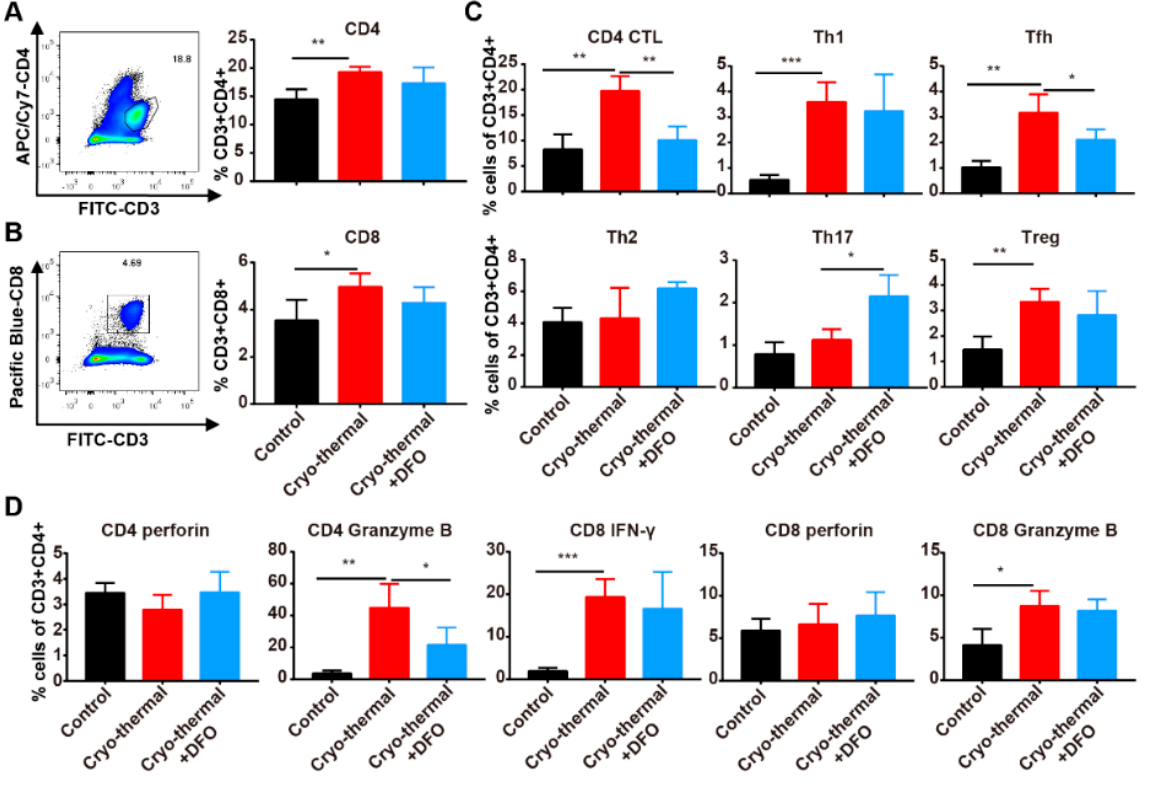
Figure 7. Iron promoted the differentiation of CD4 CTL and Tfh. Mice were sacrificed and spleens were harvested 72 h after cryo-thermal therapy. ( A , B ) The percentages of CD4 + and CD8 + T cells were measured by flow cytometry. ( C ) CD4 CTL (Thpok - ), Th1 (IFN- γ + ), Tfh (Bcl6 + ), Th2 (IL-4 + ), Th17 (IL-17 + ) and Treg (Foxp3 + ) subsets in CD4 + T cells were measured by flow cytometry. ( D ) Intracellular granzyme B, perforin and IFN- γ + in CD4 + and CD8 + T cells were determined by flow cytometry. * p < 0.05, ** p < 0.01, *** p < 0.001, n = 4 for each group.